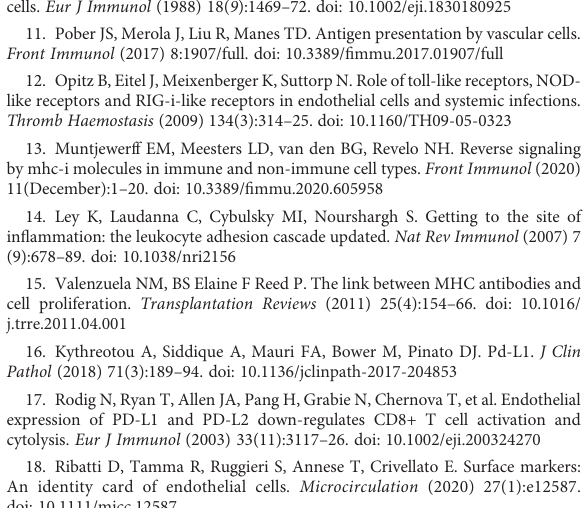
SUPPLEMENTARY FIGURE 11 Proliferation of naïve allogeneic SPs co-cultured with ECs in different conditions. (A) SPs proliferated more after 4 days of co-culture in response to freed ECs compared to substratum-adherent ECs, whether adherent to 2D TCP or 3DSF. (B) Among the freed EC groups, were total cellnumberandtarget:effectorratiowereconstant, SPsproliferatedmore when co-cultured with 2D and d3 3D freed ECs than with d14 3D freed ECs. Statistics: Ordinary one-way ANOVA.